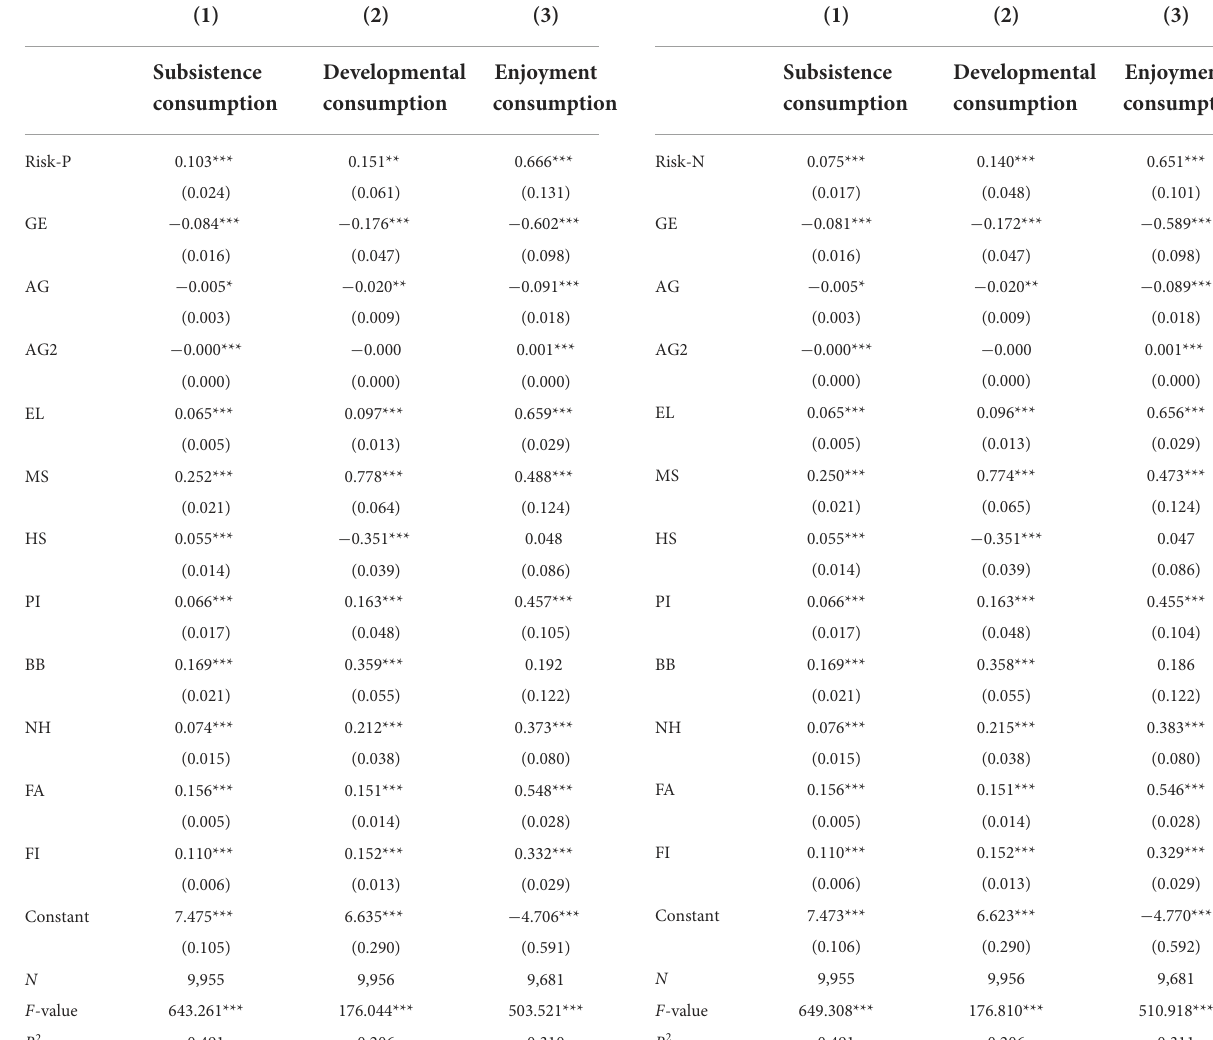
TABLE 4 The impact of risk preference on different consumption types of households.